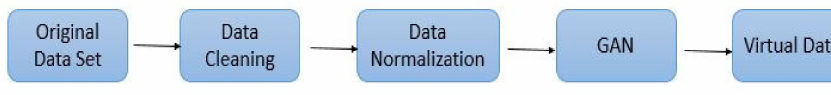
Figure 2. Processing of